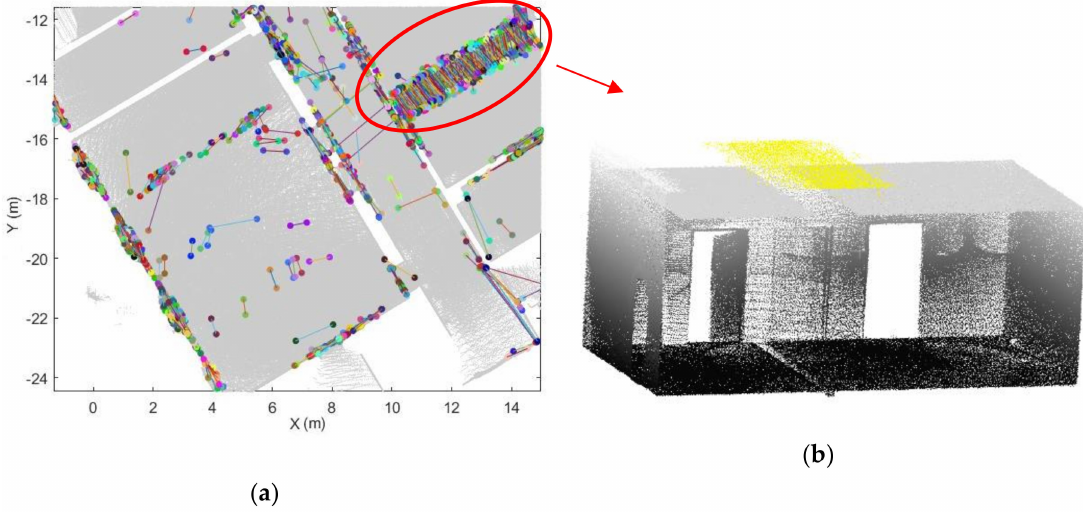
Figure 13. The effects of a horizontal gap (a) shows in xy-plane and (b) the corresponding 3D point